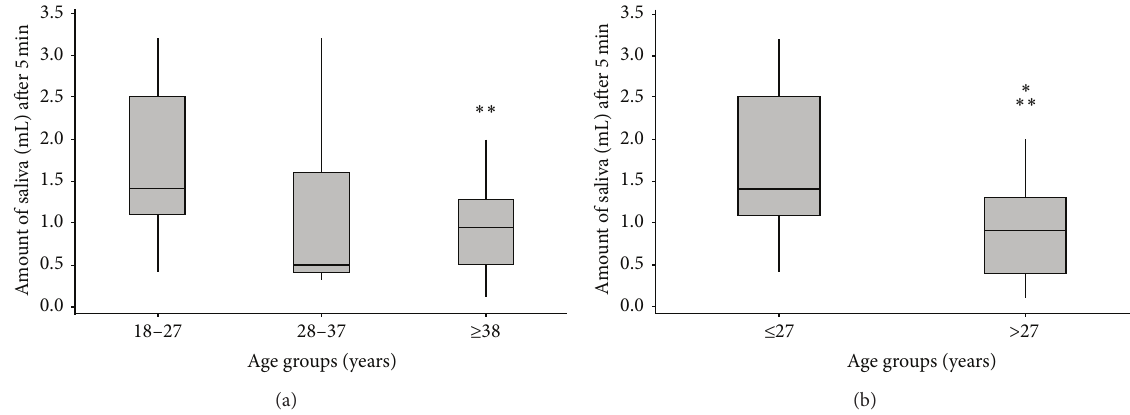
Figure 1: (a) Box plots comparing the amount of saliva by age in years. (b) Box plots comparing the amount of saliva by age in